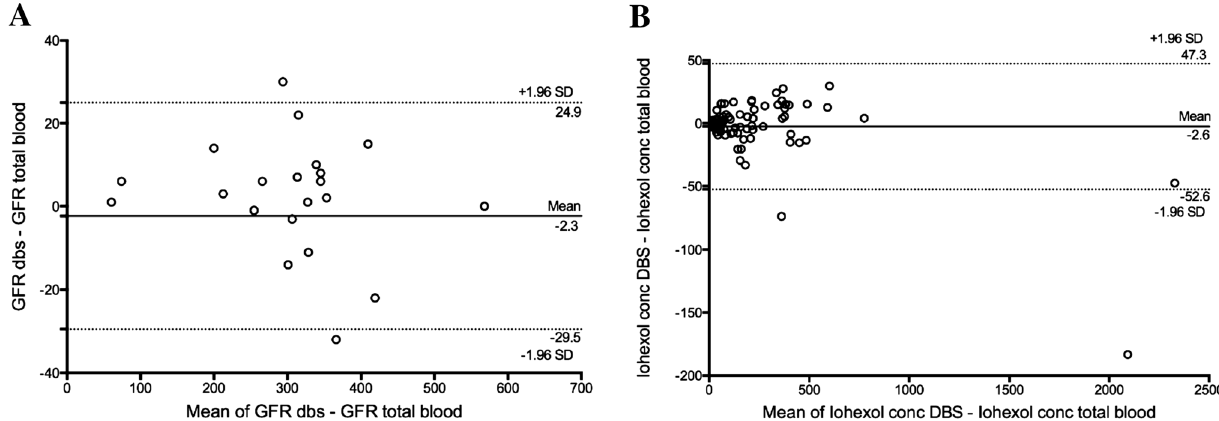
Figure 1. Bland–Altman plots and limits of agreement between ( A ) GFR values (µL/min) and ( B ) iohexol concentration values (µg/mL) both measured by the reference method in total blood and the tested method with DBS sampling. We used the GraphPad Prism software, version 6.0 (San Diego, CA; https ://www.graph pad.com). Outliers did not change the good agreement between both